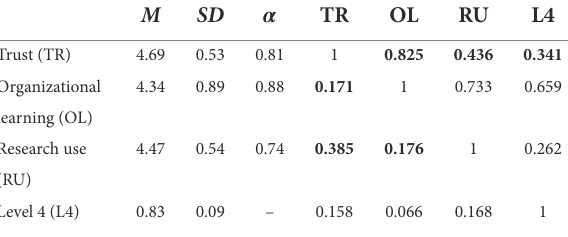
TABLE 2 Descriptive statistics, reliability, and latent correlations between the study